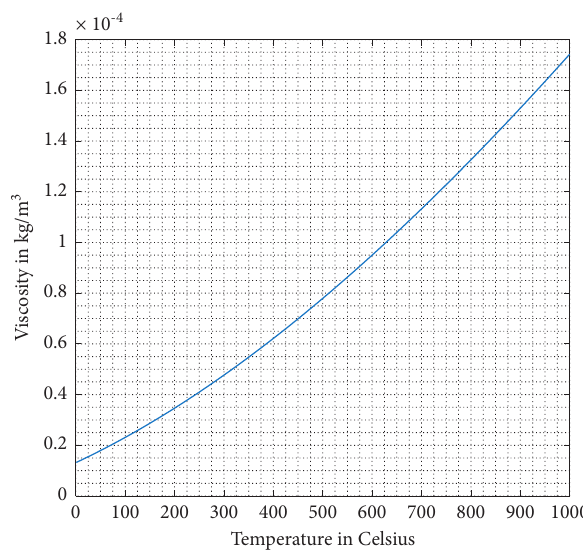
Figure 3: Viscosity of air v/s temperature.